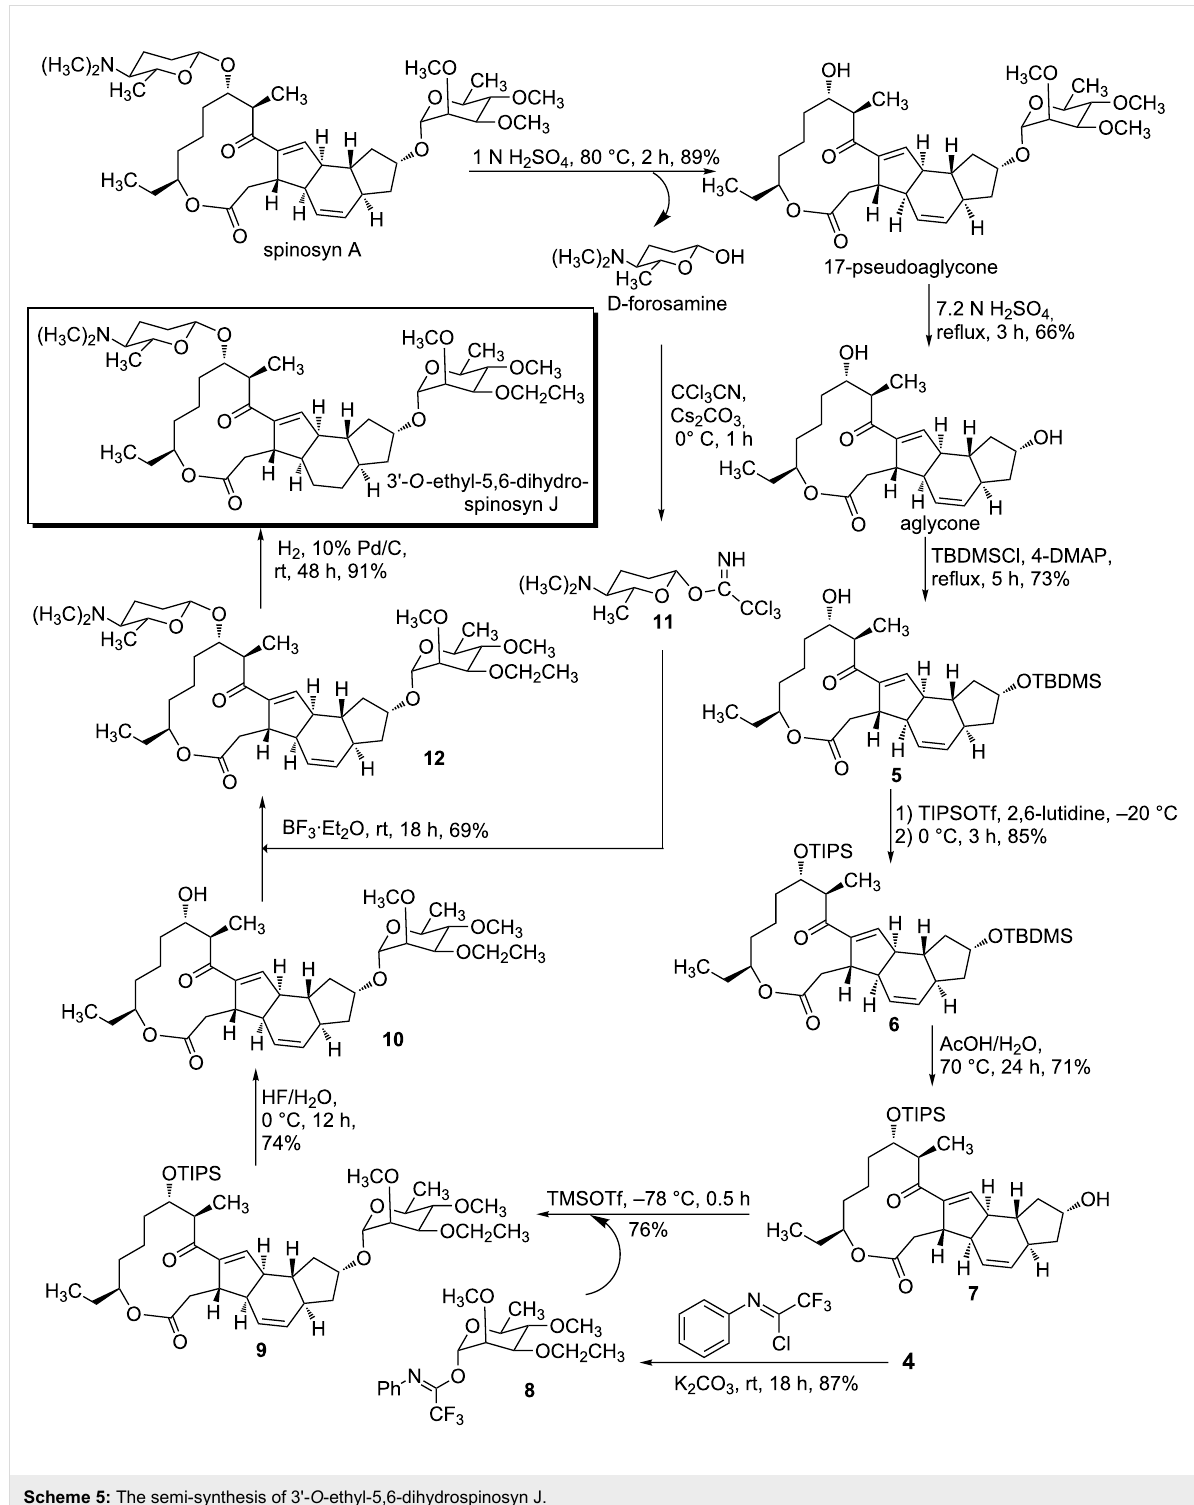
yields in each step. With this synthetic route, we achieved